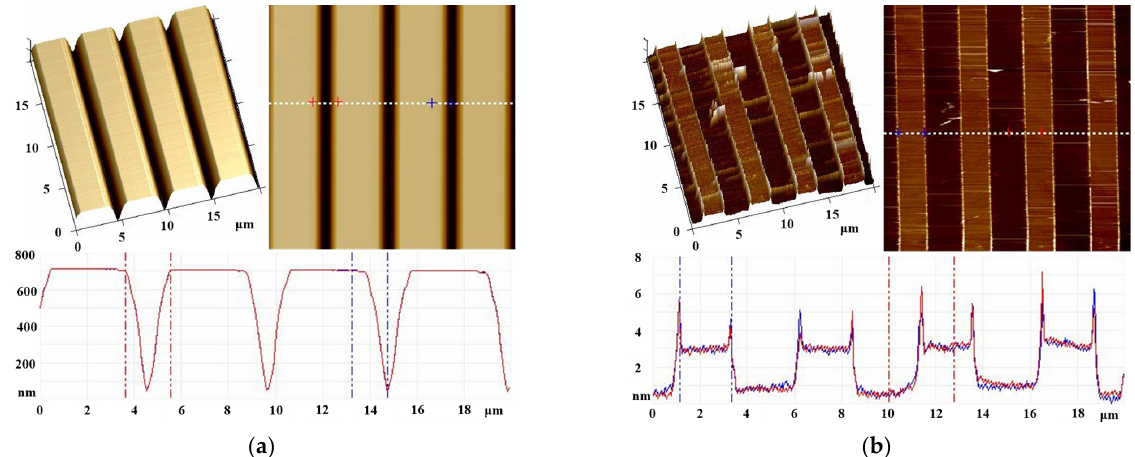
Figure 2. 2D and 3D AFM images and cross-section profiles of ( a ) photoresist templates and ( b ) DG-gel.